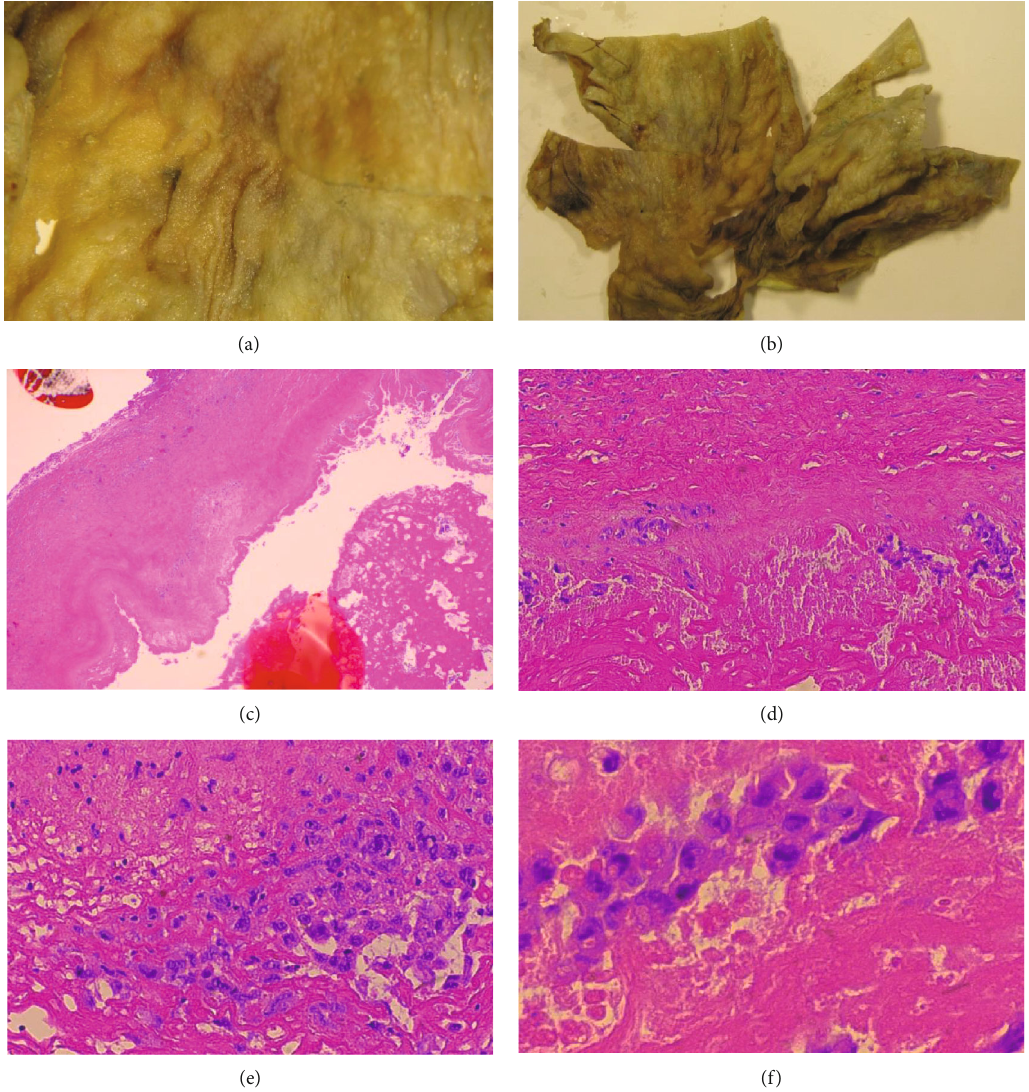
Figure 2: (a, b) Right breast capsule macroscopic appearance. Initial (malignant) capsulectomy specimen showing thickened, “ velvety ” appearance. (c – f) Right breast peri-implant capsule with exudate, microscopic appearance. Malignant lymphoid cells within the fi brinous exudate show large, irregular nuclei with prominent